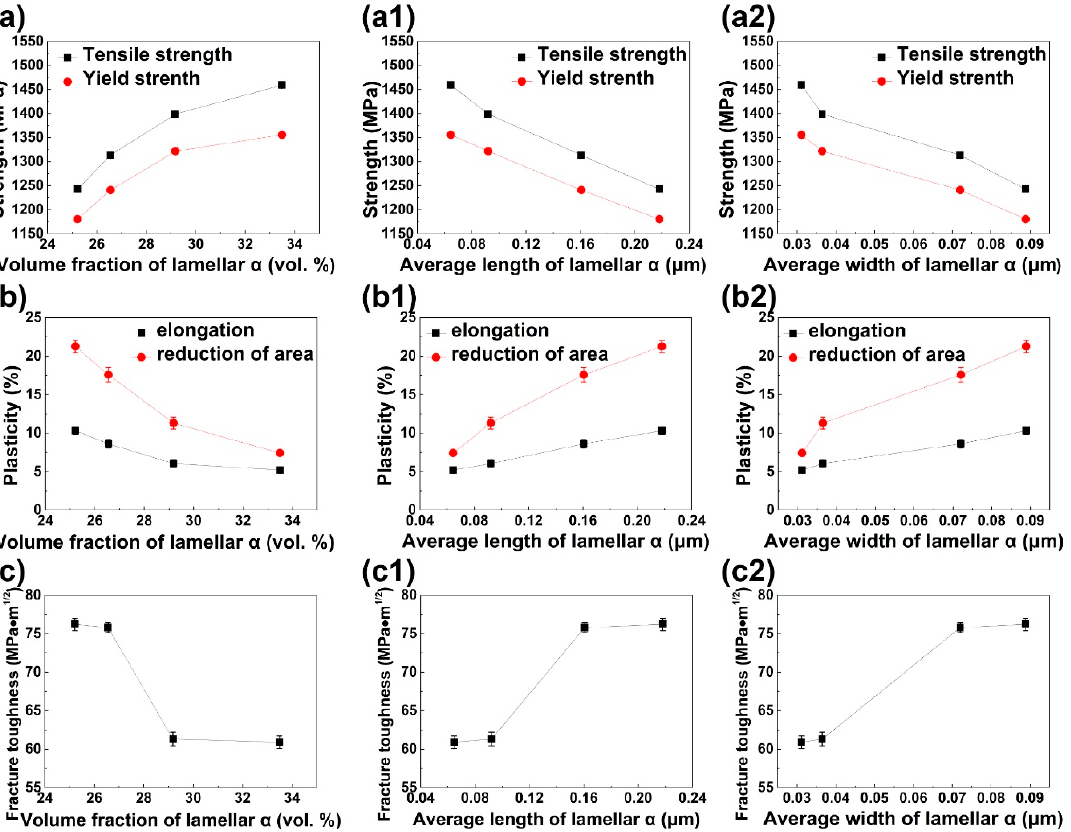
Figure 10. The variations of ( a , a1 , a2 ) strength, ( b , b1 , b2 ) plasticity, and ( c , c1 , c2 ) fracture toughness with microstructure features of ( a – c ) volume fraction of α lamellar , ( a1 – c1 ) average length of α lamellar , and( a2 – c2 ) average width of α lamellar .